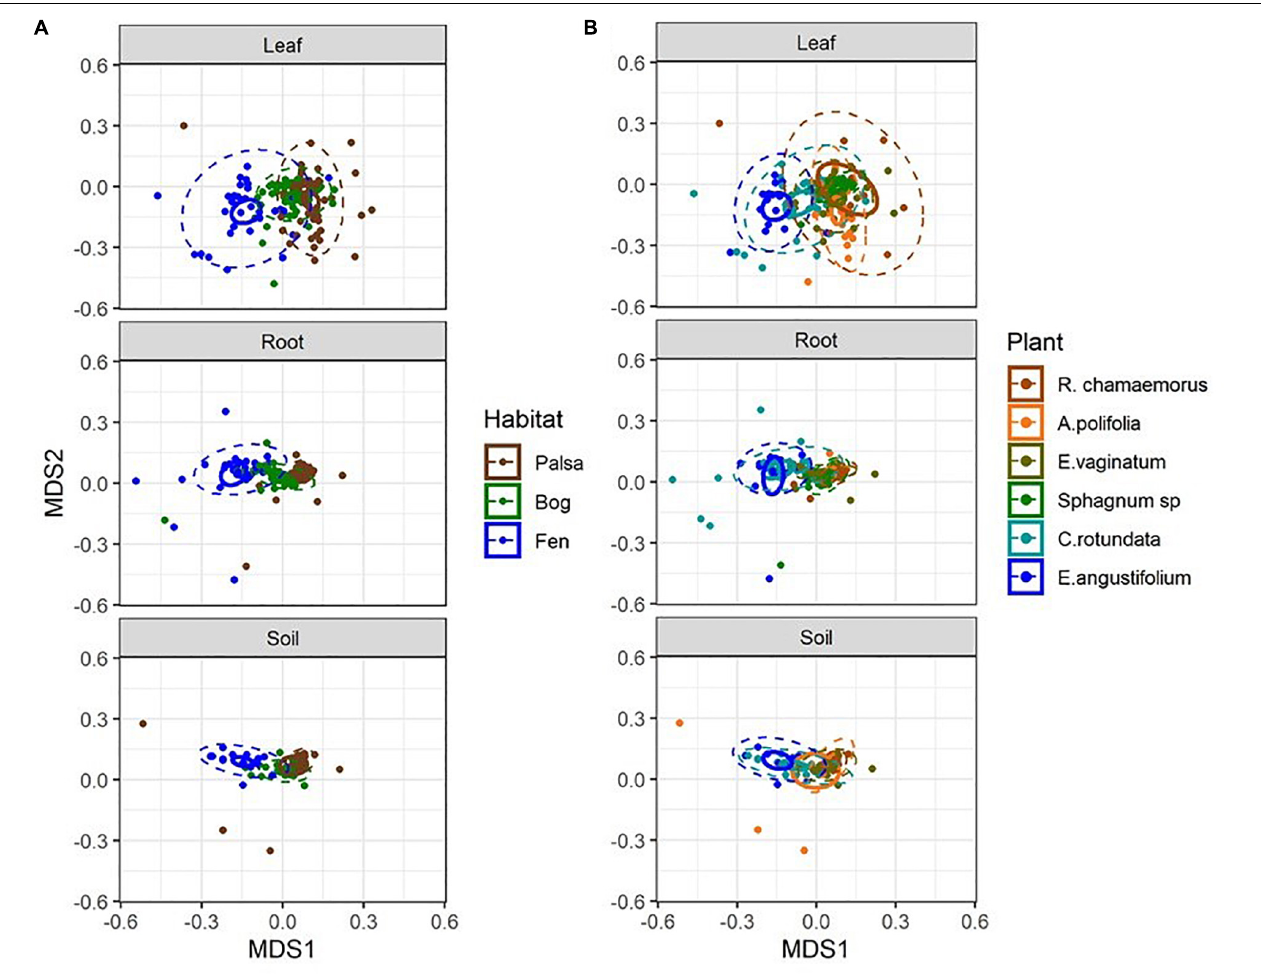
FIGURE 4 | NMDS plots of Bray–Curtis distances separated by compartment and color-coded by (A) habitat type and (B) plant associate. Outer ellipses include 95% of points for a group, inner ellipses are 95% confidence around the centroid. Stress = 0.17.